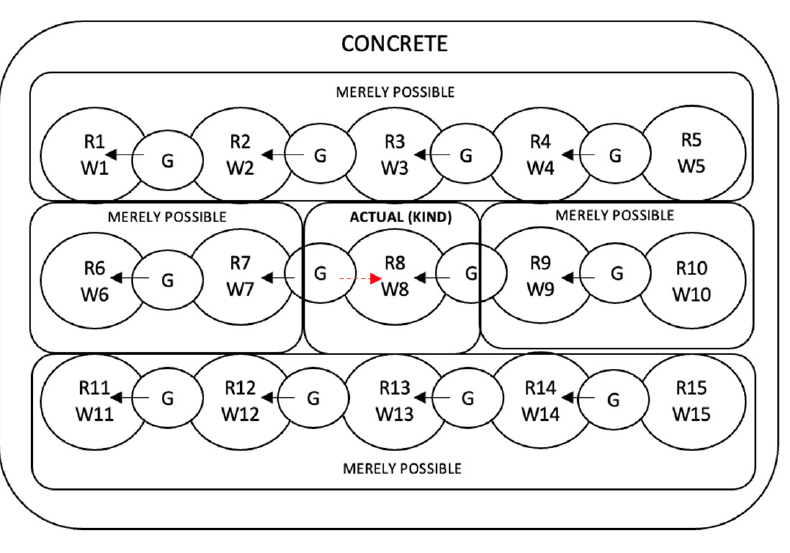
Figure 7. Leibnizian Realism with Overlap (ii).